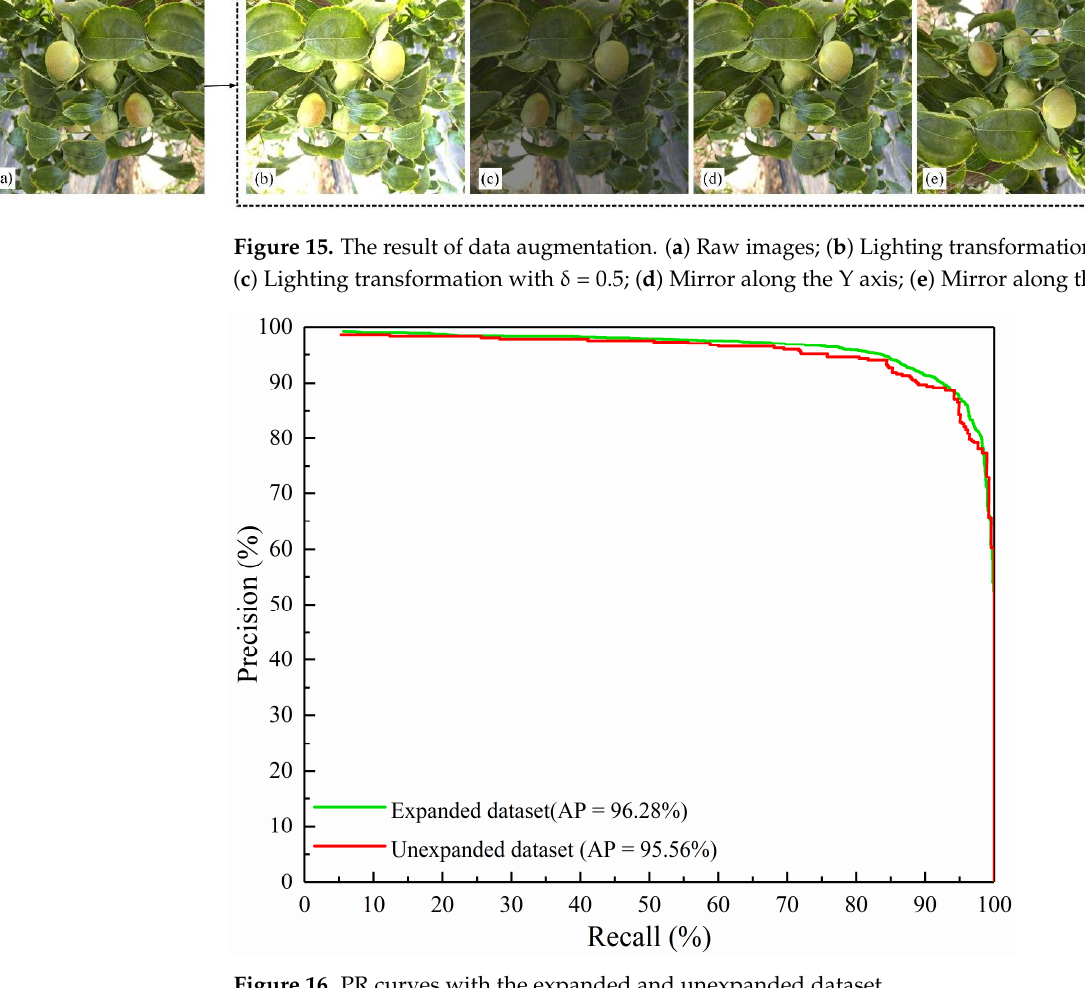
Figure 16. PR curves with the expanded and unexpanded